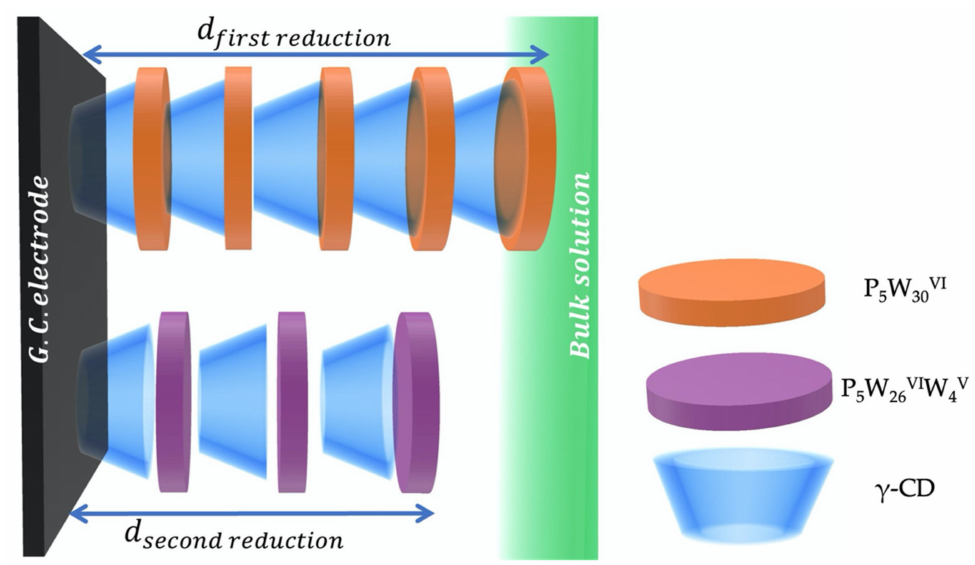
Figure 6. Illustration of the accumulation of POM–CD molecules on the surface of a glassy carbon electrode highlighting the increase in the diffusion layer thickness ( d ) between the first and the second reduction of the